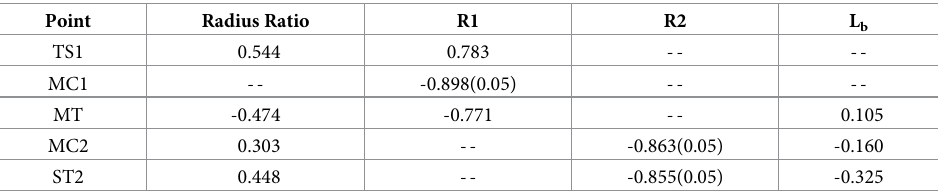
Table 7. Correlation analysis of D of reverse curves